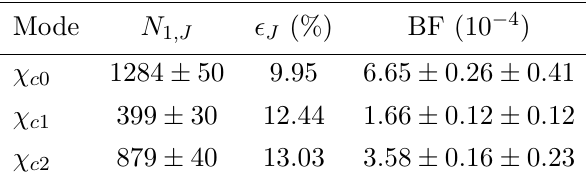
Table 1 . The number of fitted signal events ( N 1 ,J ), detection efficiency ( (cid:15) J ), and B ( χ cJ → nK 0 c . c . ) , where the first uncertainty is statistical and the second one is systematic.